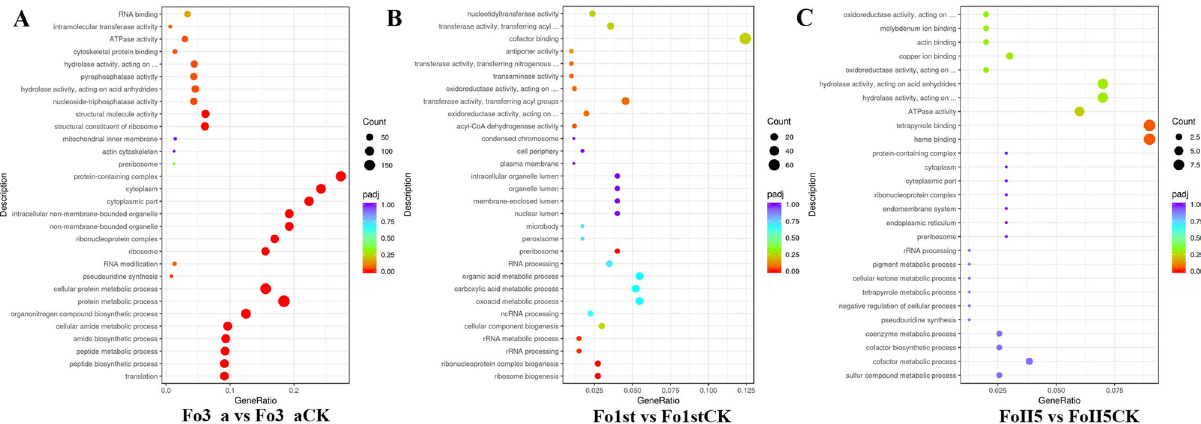
Figure 3. GO enrichment analysis of DEGs in all comparison groups. The top 30 most enriched GO categories were shown in a scatter diagram in the comparison groups ( A ) Fo3_a vs Fo3_aCK and ( B ) Fo1st vs Fo1stCK ( C ) FoII5 vs FoII5CK. The abscissa represents the ratio of the number of differential genes annotated on GO term to the total number of differential genes and the ordinate represents GO term. The size of small dots represents the number of genes annotated to GO term, the color from red to purple represents the significance of enrichment, and p adj < 0.05 is used as the threshold of significance enrichment for GO enrichment